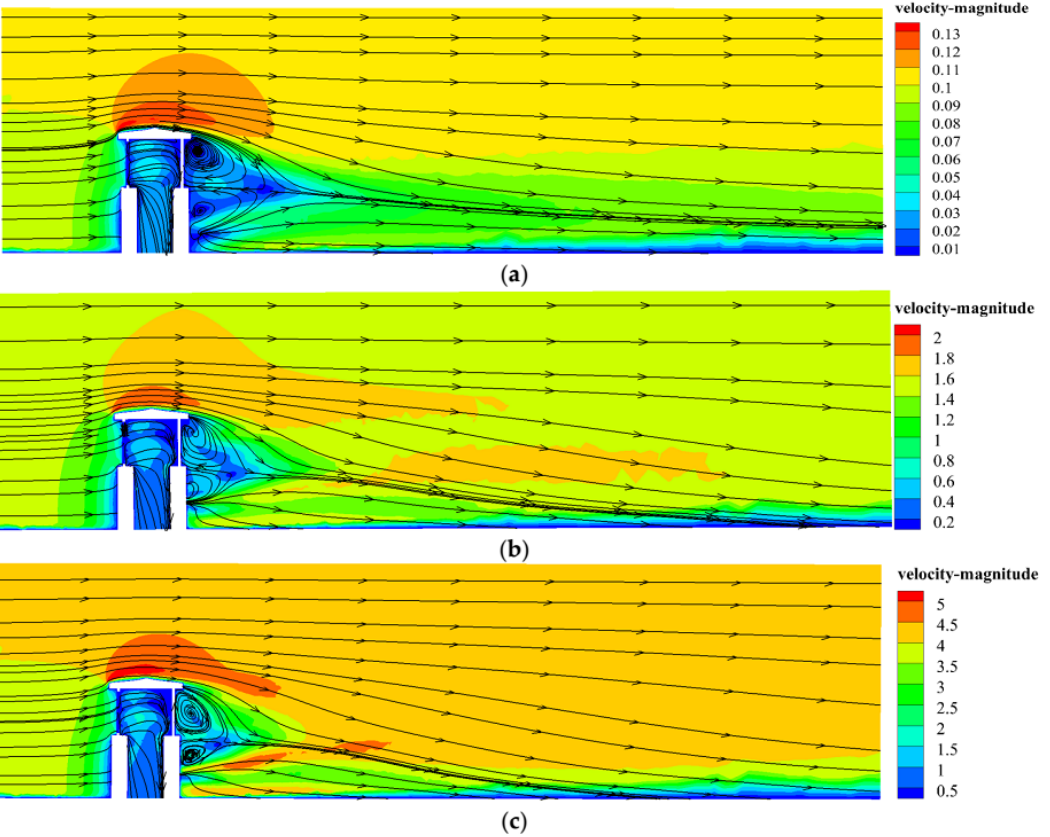
Figure 11. Distribution of velocity and streamlines evolution in xz-plane for different inlet wind velocities: ( a ) 0.1 m/s, ( b ) 1.5 m/s, and ( c ) 4 m/s.